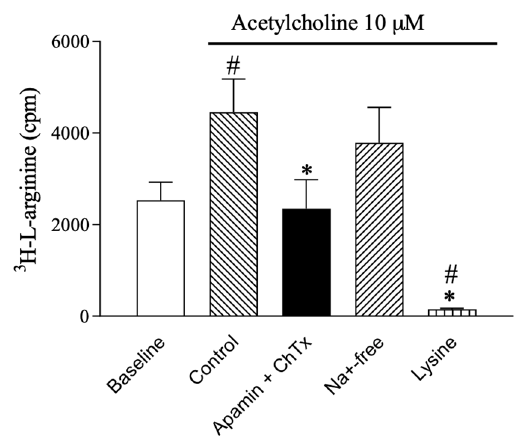
Figure 1. 3 H- L -arginine uptake in rat aortic valve endothelial cells in the absence and presence of the combination of apamin (0.5 µM), a SKCa channel blocker, and charybdotoxin (ChTX, 0.1 µM), an IKCa channel blocker, and of L -lysine (600 µM), both inhibiting L -arginine uptake through the CAT system, and of low Na + -PSS which inhibits L-arginine uptake through the Na + -dependent (Bo,+) CAT system. Data are means ± S.E.M. ( n = 6). One-way ANOVA. # p < 0.05 vs. baseline. * p < 0.05 vs. control.